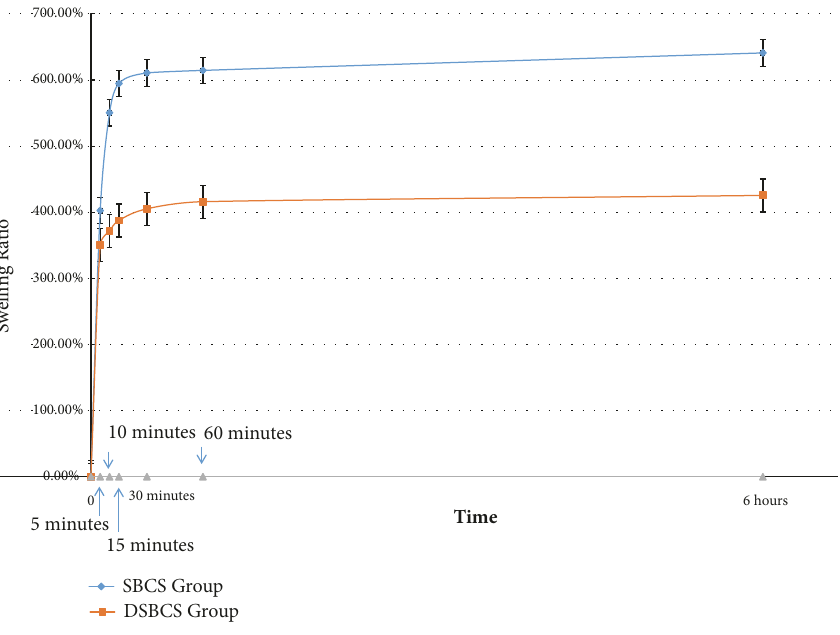
Figure 8: Plot of swelling ratio assessment in 6 hours. The error bars represent the standard deviation of measurements for 6 points of time in 5 separate sample runs (n = 30) in each scaffold